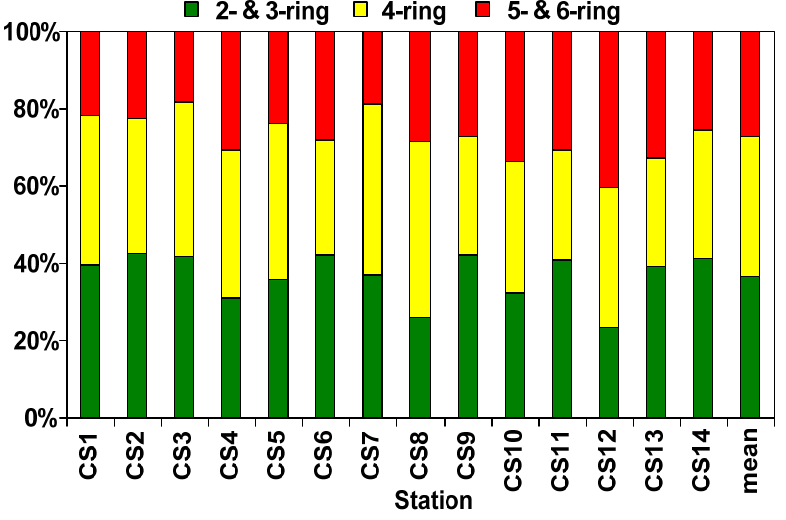
Figure 4. PAHs composition in sediments of industrial port area of southern Kaohsiung Harbor, 2- & 3-ring: NA, ACY, ACE, FL, PH, AN. 4-ring: FLU, PY, BaA, CH. 5- & 6-ring: BbF, BkF, BaP, IP, DA, BP.